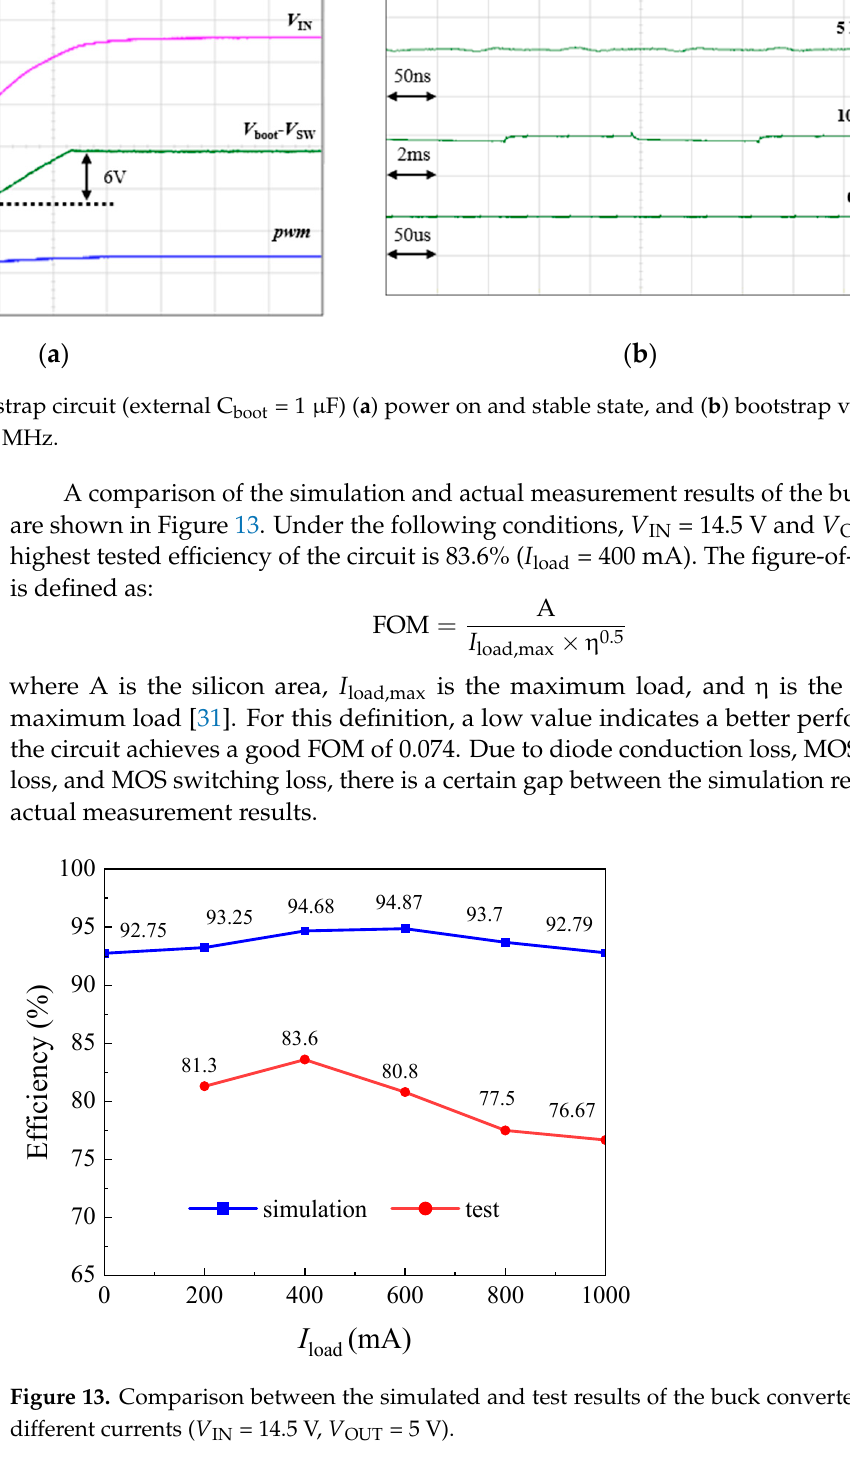
Figure 11. Simulation results of buck converter ( V IN = 14.5 V, V OUT = 5 V, I load = 1 A).